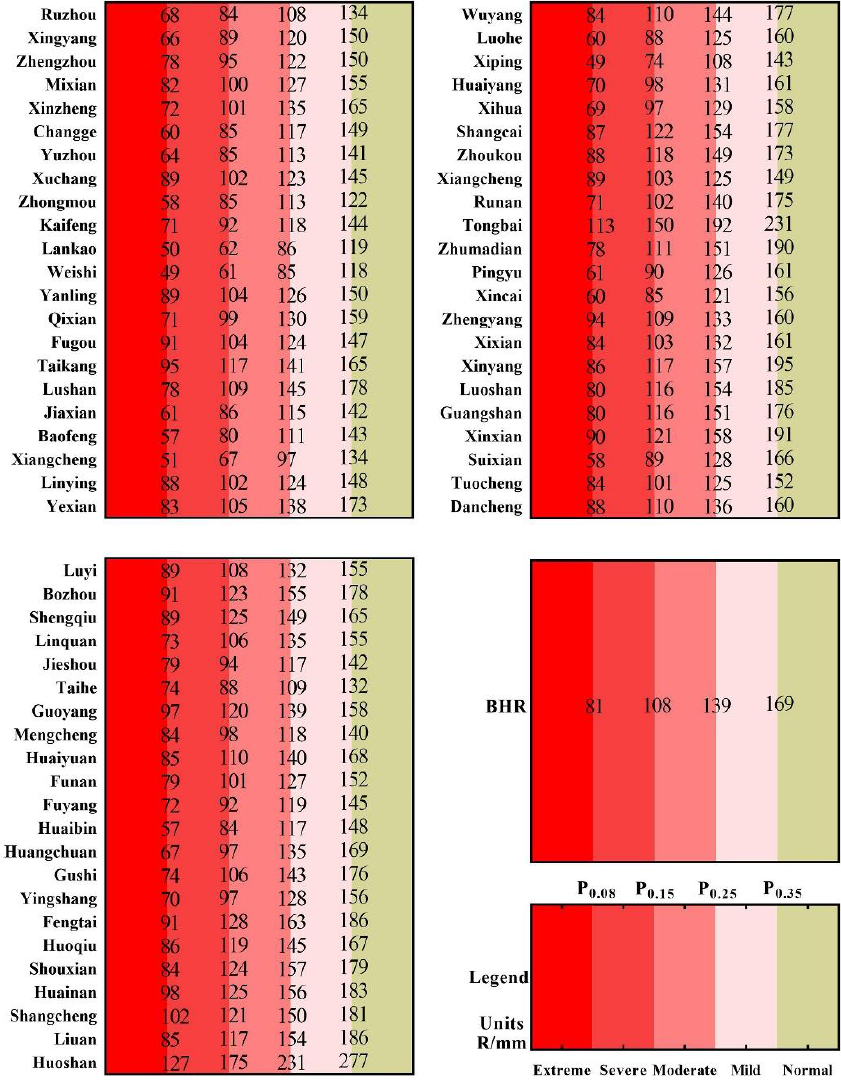
Figure 5. Precipitation thresholds R (mm) of drought disaster during the critical water period during summer maize growth in the BHR. Note: BHR represent in areas in front of Bengbu Sluice in the Huaihe River Basin. R represents precipitation thresholds (mm).